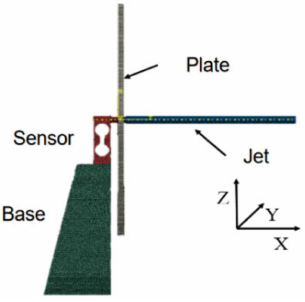
Figure 2. The numerical simulation graph of jet impact model. Table 2. The categories of material and element of parts.